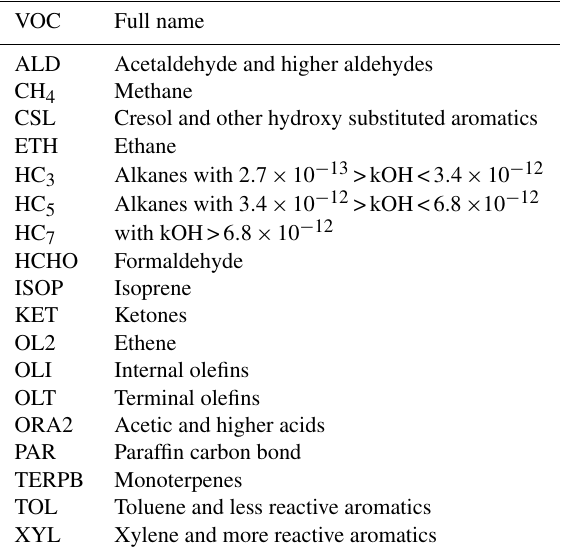
Table 2. VOCs in the emissions